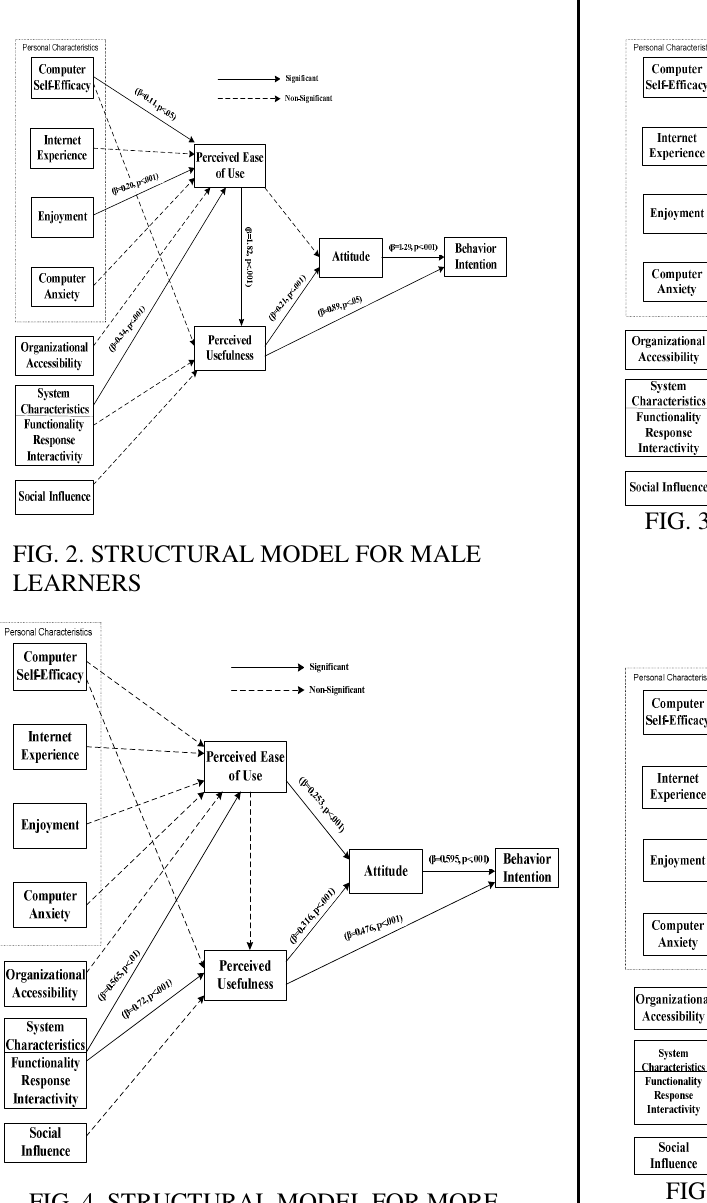
FIG. 4. STRUCTURAL MODEL FOR MORE